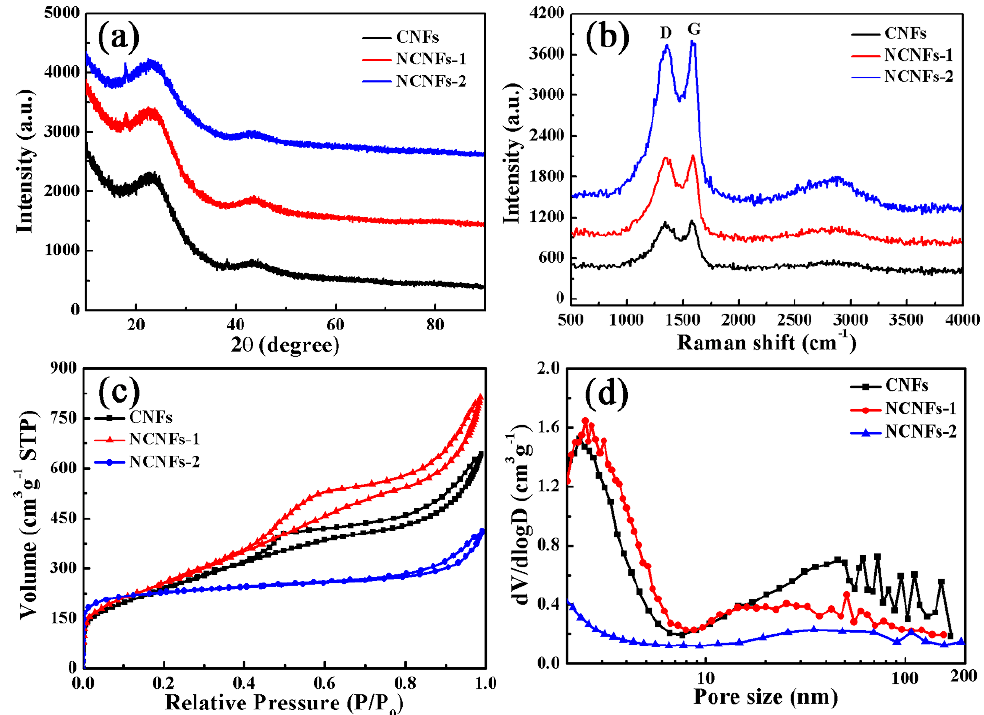
Figure 4. XRD ( a ), Raman ( b ) and nitrogen adsorption / desorption isotherms; ( c ) measurements for CNFs and different N-doped CNF samples. ( d ) Shows the calculated pore size distributions for corresponding samples.